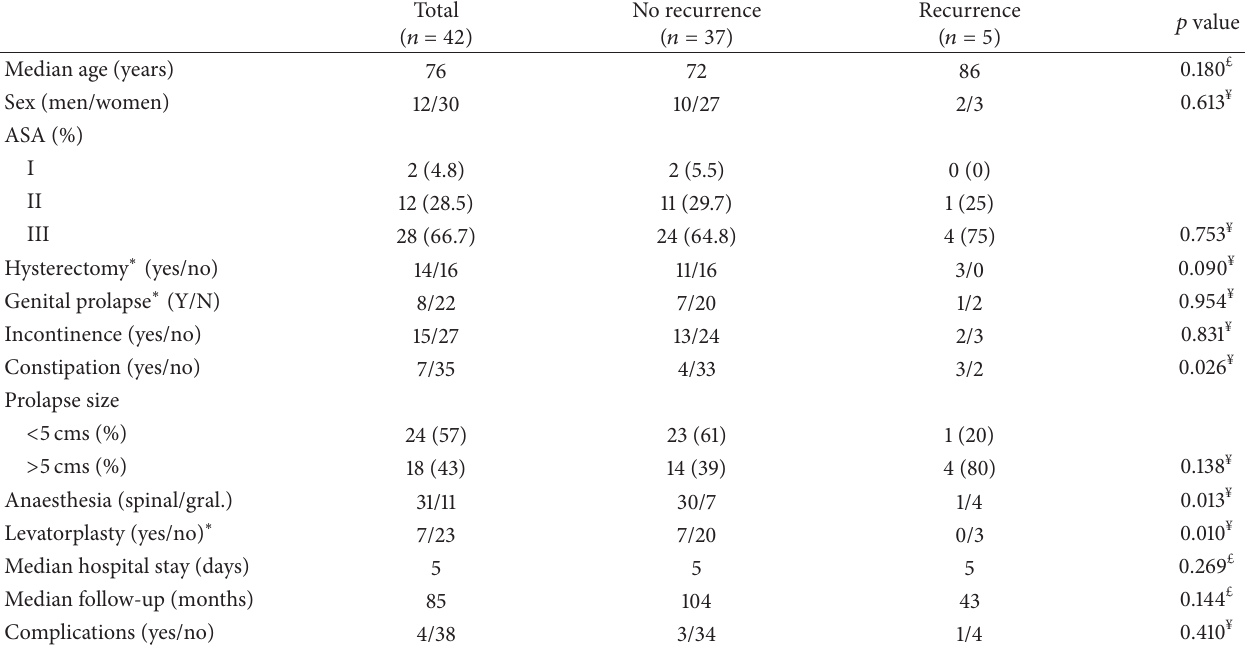
Table 1: Baseline characteristics of rectal prolapse patients.